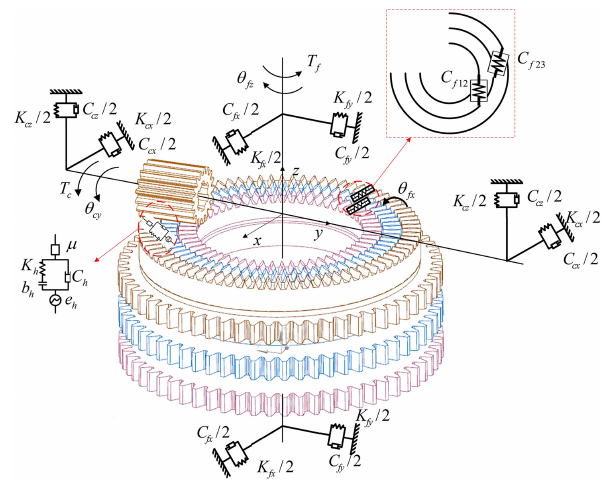
Figure 2. Kinematics model of multistage face